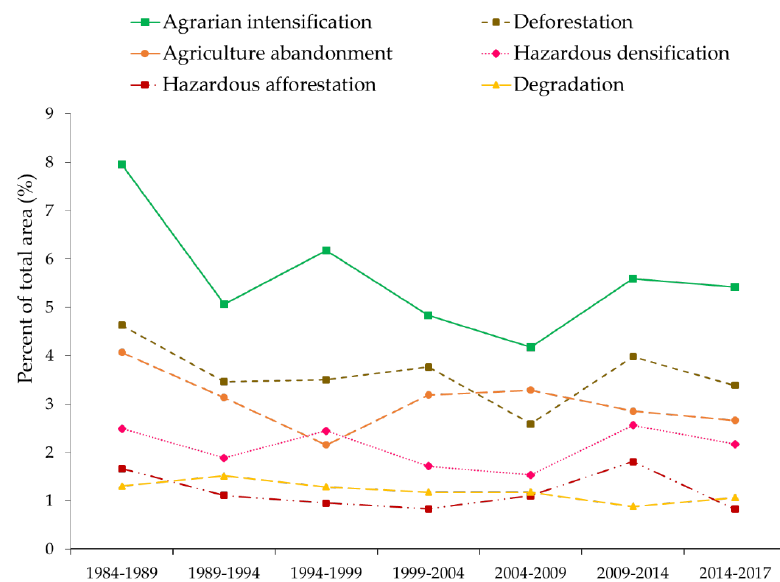
Figure 10. Rates of change between the first and last five-year periods for the processes derived from LULC changes.